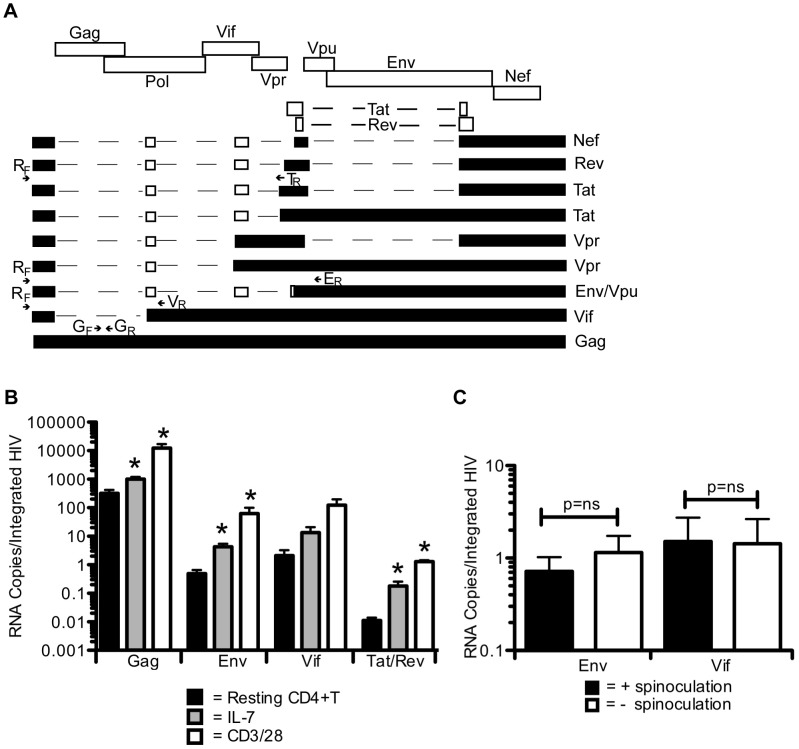
Protein expression differences are reflected at the transcript level.A schematic showing the different HIV RNA species and the primers used to detect them is shown in A. The upper portion depicts the viral genome while the lower portion depicts the various RNA transcripts. For the different RNA species, black boxes represent regions present in all forms of the indicated viral transcript while white boxes represent regions that may or may not be present. GF and GR were used to detect gag levels. RF and ER were used to detect env. RF and VR were used to detect vif, and RF and TR were used to detect tat/rev. Primers were confirmed to solely detect their respective products by gel electrophoresis. Cells were treated and infected as in Figure 4. Cells were cultured in the presence or absence of the integrase inhibitor, raltegravir. RNA was collected at 72 hours (48 hours in CD3/28 treated cells). RNA levels were calculated per cell and were normalized to integration levels. gag levels were obtained by subtracting the levels of gag/cell in the raltegravir treated fraction from the levels in the - raltegravir fraction. An average of 3 experiments in 3 different donors is shown (B). In C, resting cells were infected with or without spinoculation and env and vif levels were measured as in B. An average of 3 experiments in 3 different donors is shown. Error bars represent the standard error of the measurements. *Statistically different at the p<0.05 level.